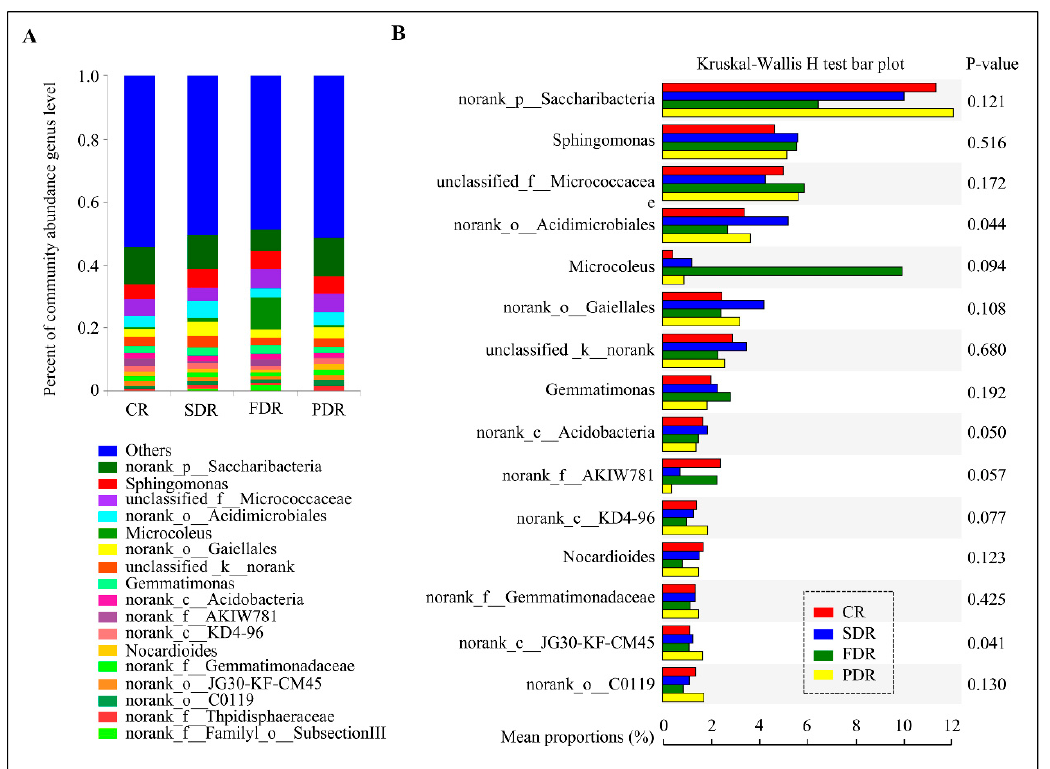
Figure 3. Microbial community structure and diversity in drought-treated and untreated peanut rhizosphere. ( A ) Percent of microbial community abundance at the genus level in four soil groups in peanut rhizosphere. The relative abundance is calculated by averaging the abundances of duplicate samples. ( B ) Microbial community diversity in drought-treated and untreated peanut rhizosphere via Wilcoxon rank-sum test bar plot. Left image represents the proportions of various genera in four soil groups. Right image represents the di ff erence between proportions in 95% confidence intervals. The names of “norank” and “unidentified” are all unidentified species obtained directly from database via sequence alignment.